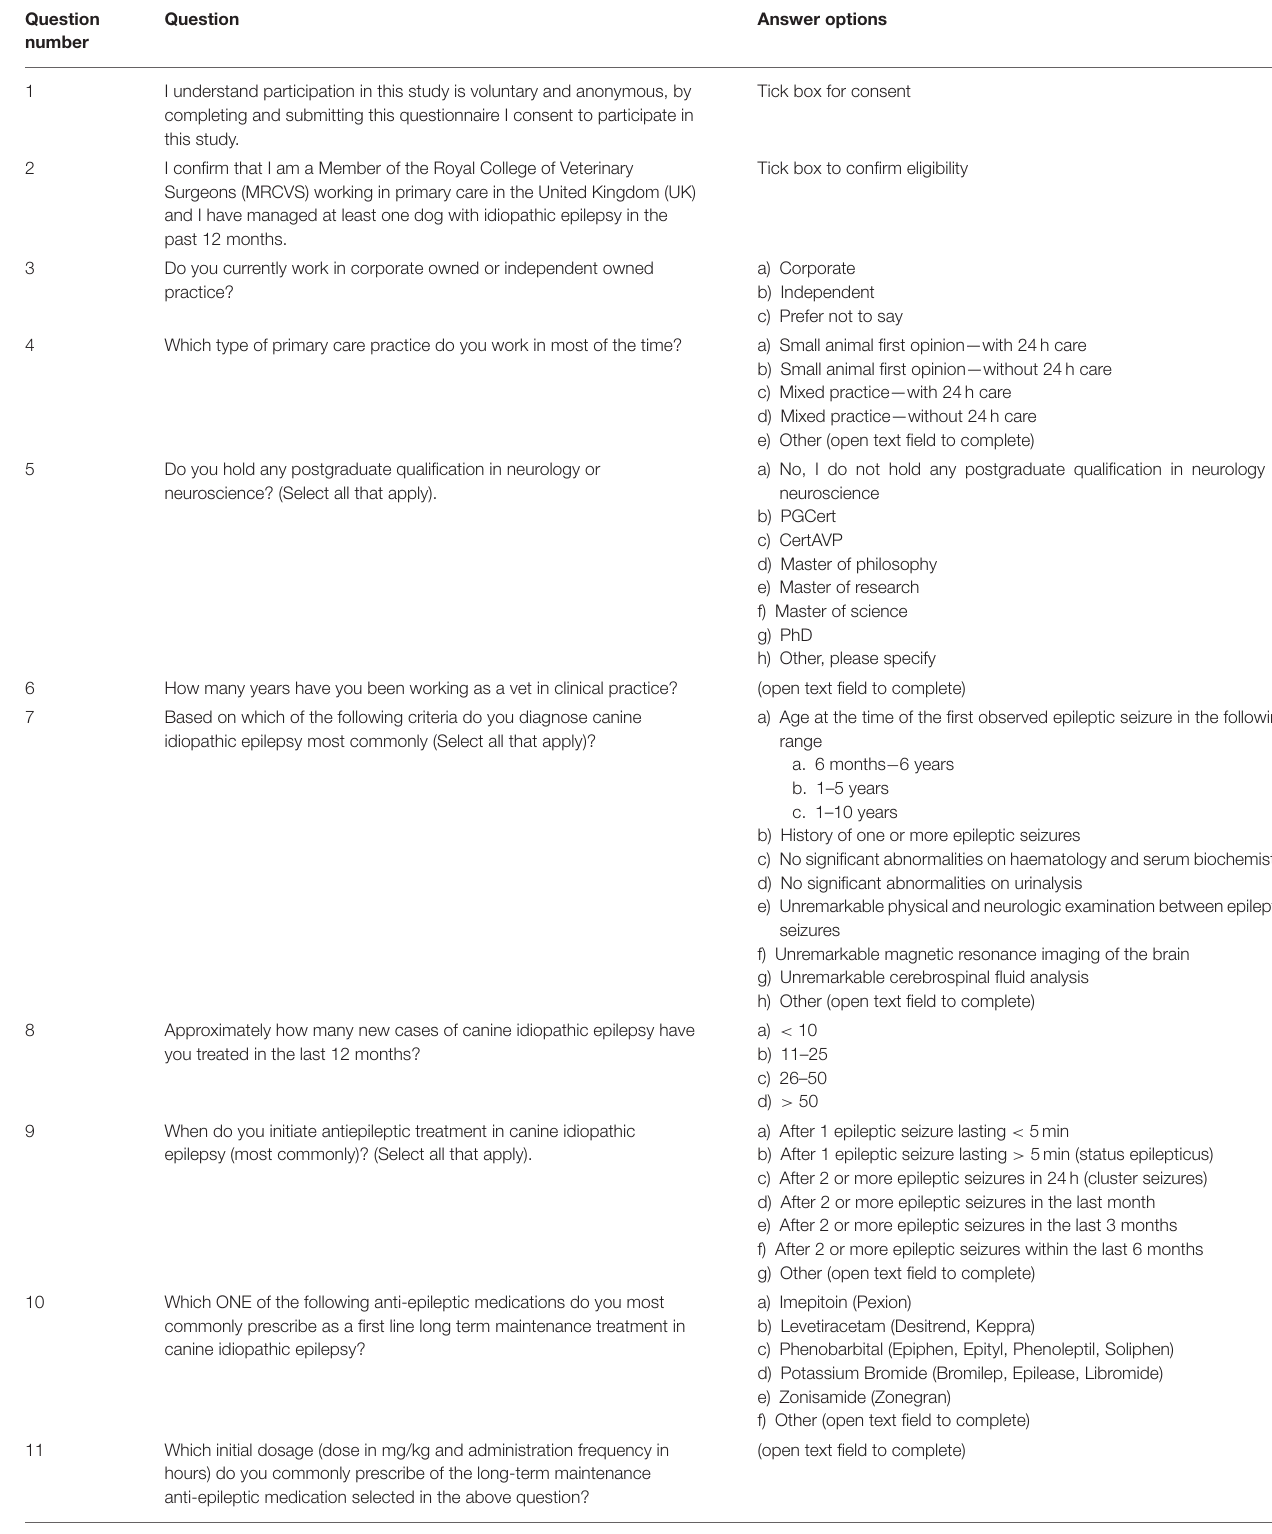
TABLE 1 | Questionnaire used in the cross-sectional survey of canine idiopathic epilepsy management in primary care in the United Kingdom. Question